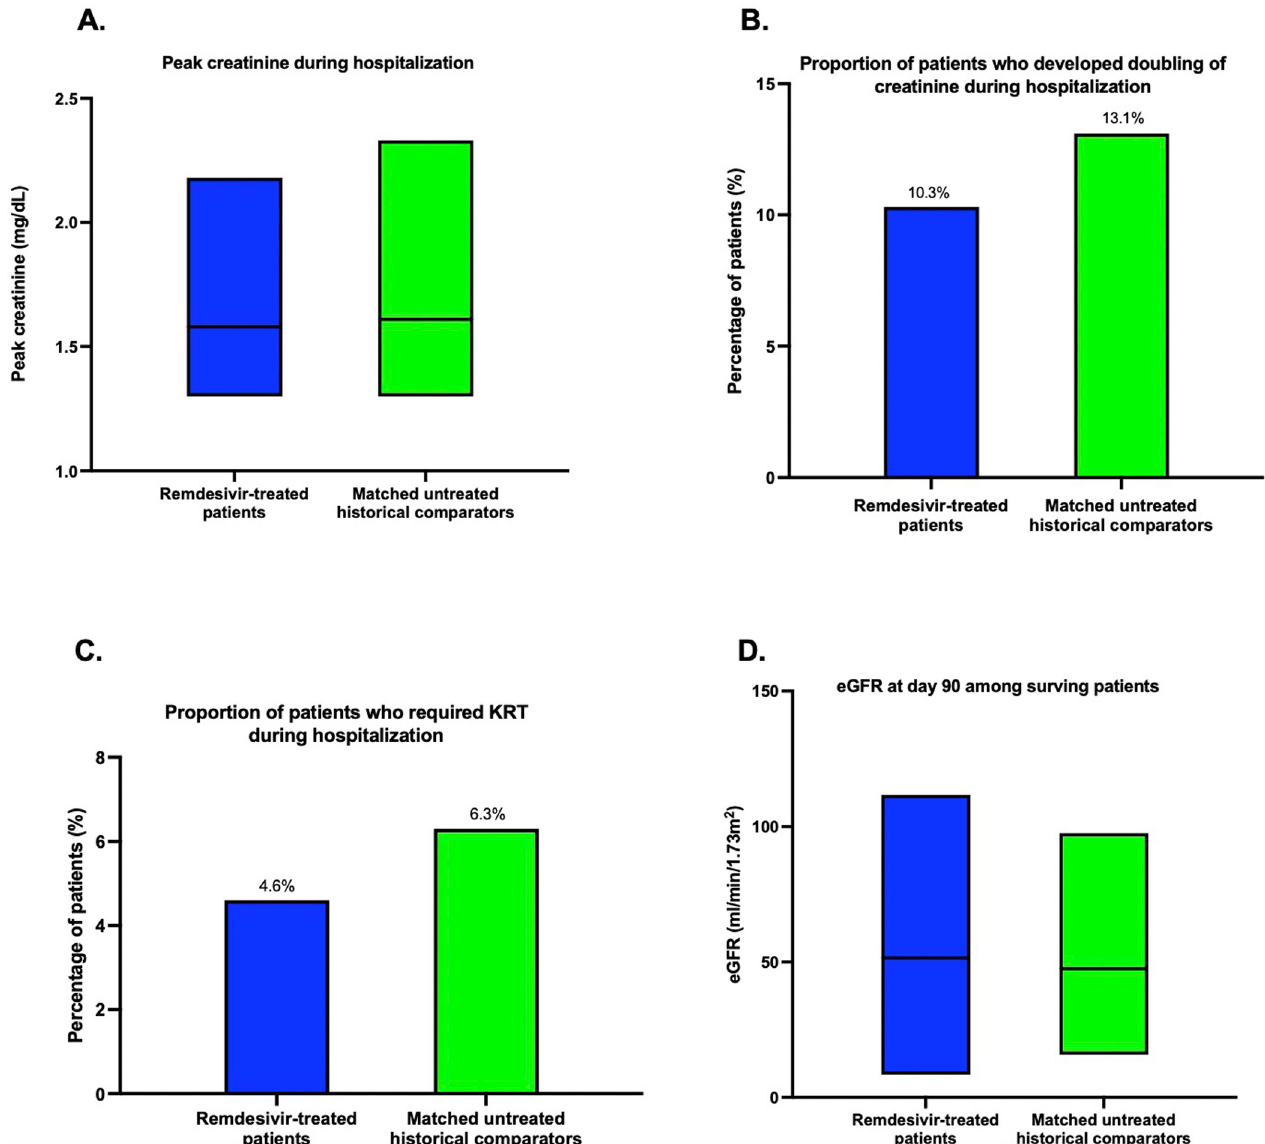
Fig 2. Kidney outcomes in remdesivir-treated patients and propensity score matched untreated historical comparators. There was no statistically significant difference in any of the adverse kidney outcomes. A) Peak creatinine during hospitalization B) Percentage of patients developed doubling of creatinine C) Percentage of patients requiring initiation of kidney replacement therapy D) eGFR at day 90 among surviving patients. Boxplot (2A, 2D) showed the 1 st quartile, median and 3 rd quartile of peak creatinine and day 90 eGFR, respectively. Abbreviation: KRT: kidney replacement therapy; eGFR: estimated glomerular filtration